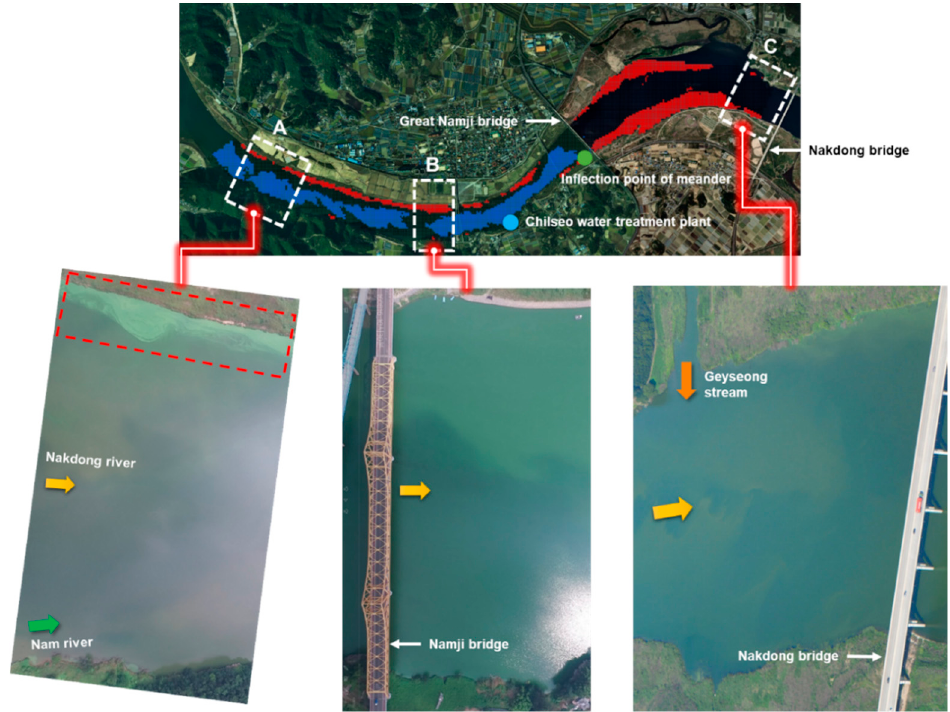
Figure 8. A comparison between the HAB-prone regions and UAV-based photographs to visually inspect algal bloom occurrences, where the specified areas of A, B, and C were located at the upper, middle, lower regions of the study area to individually represent the impacts of confluence, meandering and adjacent water intake, and channel width expansion, respectively. These figures also show the location of Chilseo drinking water intake, as well as Nam River and Geyseong stream as tributaries located in the upstream and downstream reaches, respectively. Note that the HAB-prone regions were derived from a hot-spot analysis using Getis-Ord G* based solely on ADCP measurements, where the red-colored areas indicate areas susceptible to algal